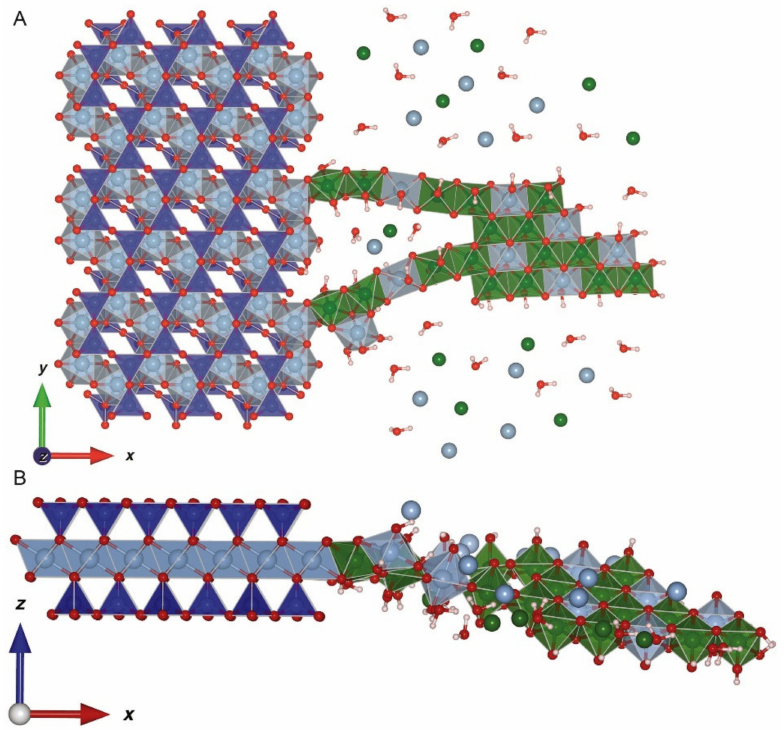
Figure 7. Two views (top of (001) plane in panel ( A ) and side view in panel ( B )) of layered double hydroxide mineral surface precipitates (green, blue, and red) on a clay mineral (blue and red). Image adapted from [24] with